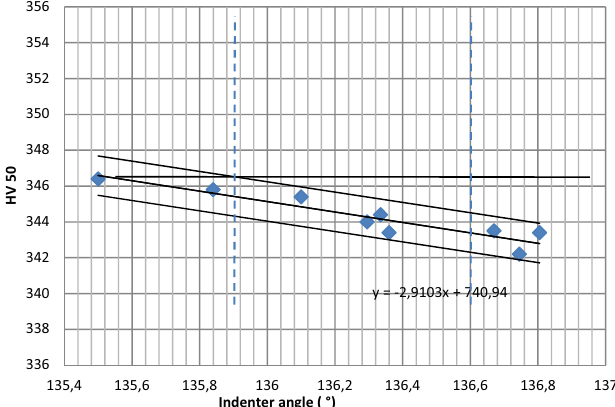
Fig. 5. (Color online) Relation between angle of the indenter and hardness No (345 HV50).